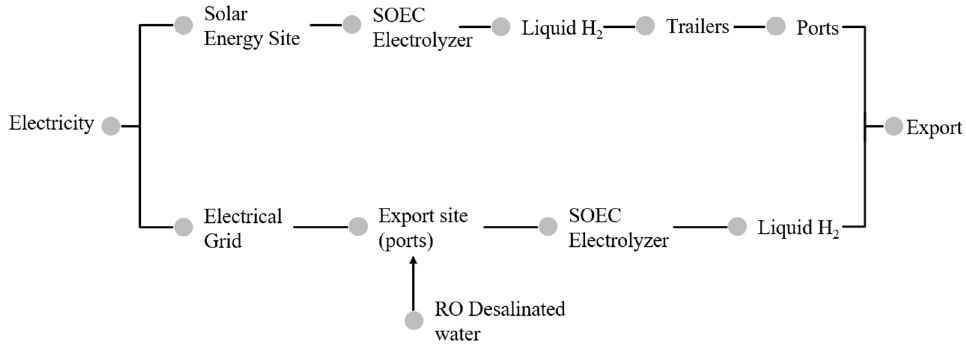
Figure 3. Pathways’ layout.